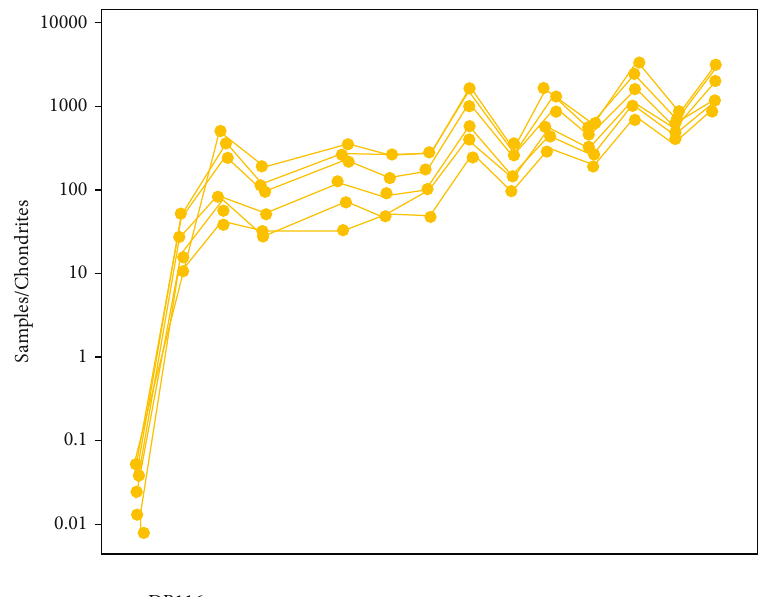
Figure 4: Normalized partition pattern of massive eclogite zircon